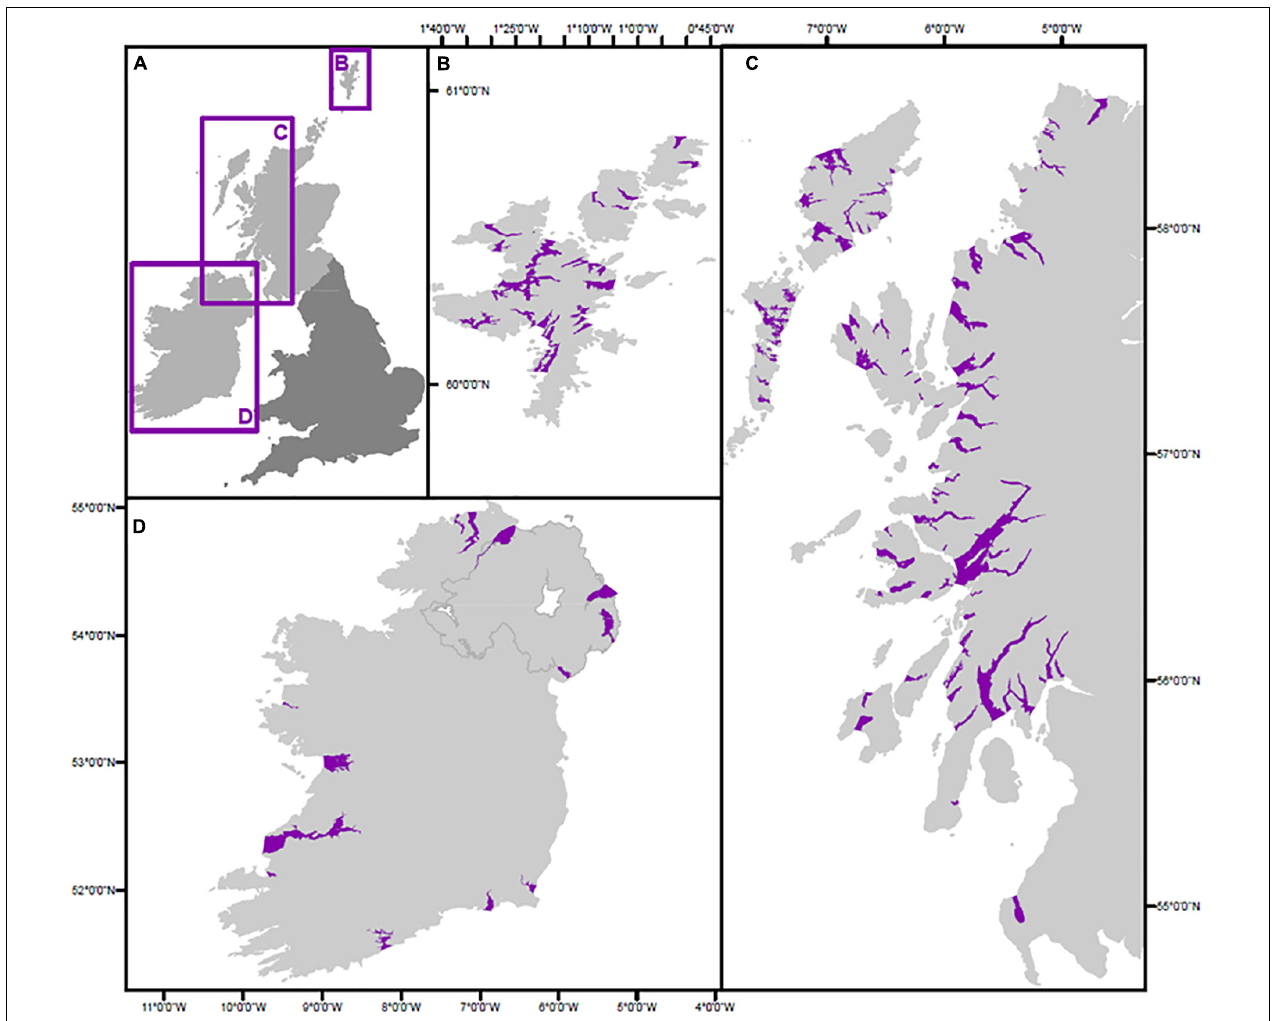
FIGURE 1 | (A) Overview map illustrating the different regions focused on in this study. Maps highlighting the individual fjords of the (B) Shetland Islands, (C) Scottish Mainland and Inner and Outer Hebrides and (D) Northern and Republic of